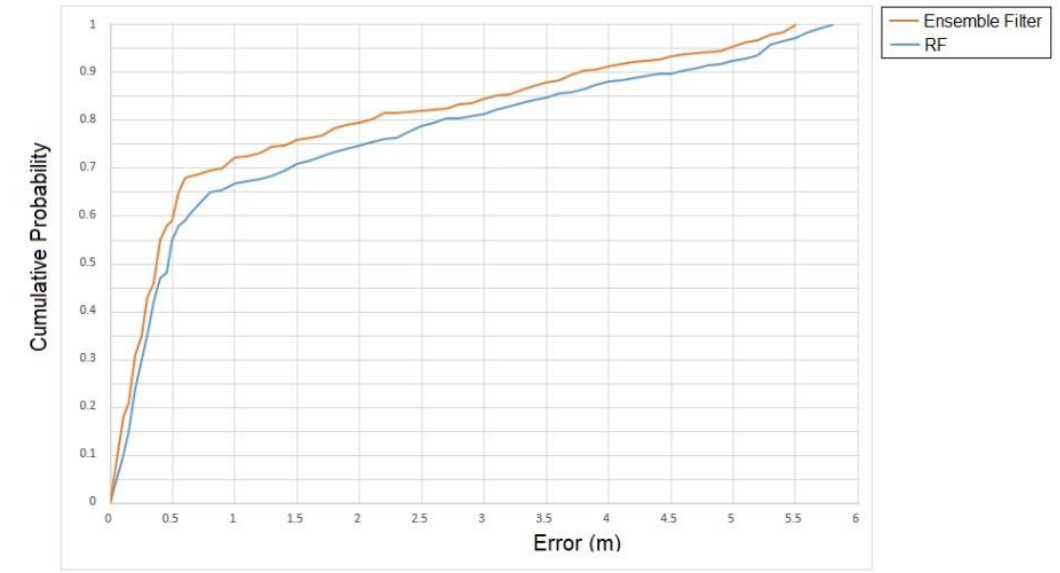
Figure 12. Positioning error for the proposed ensemble filter.